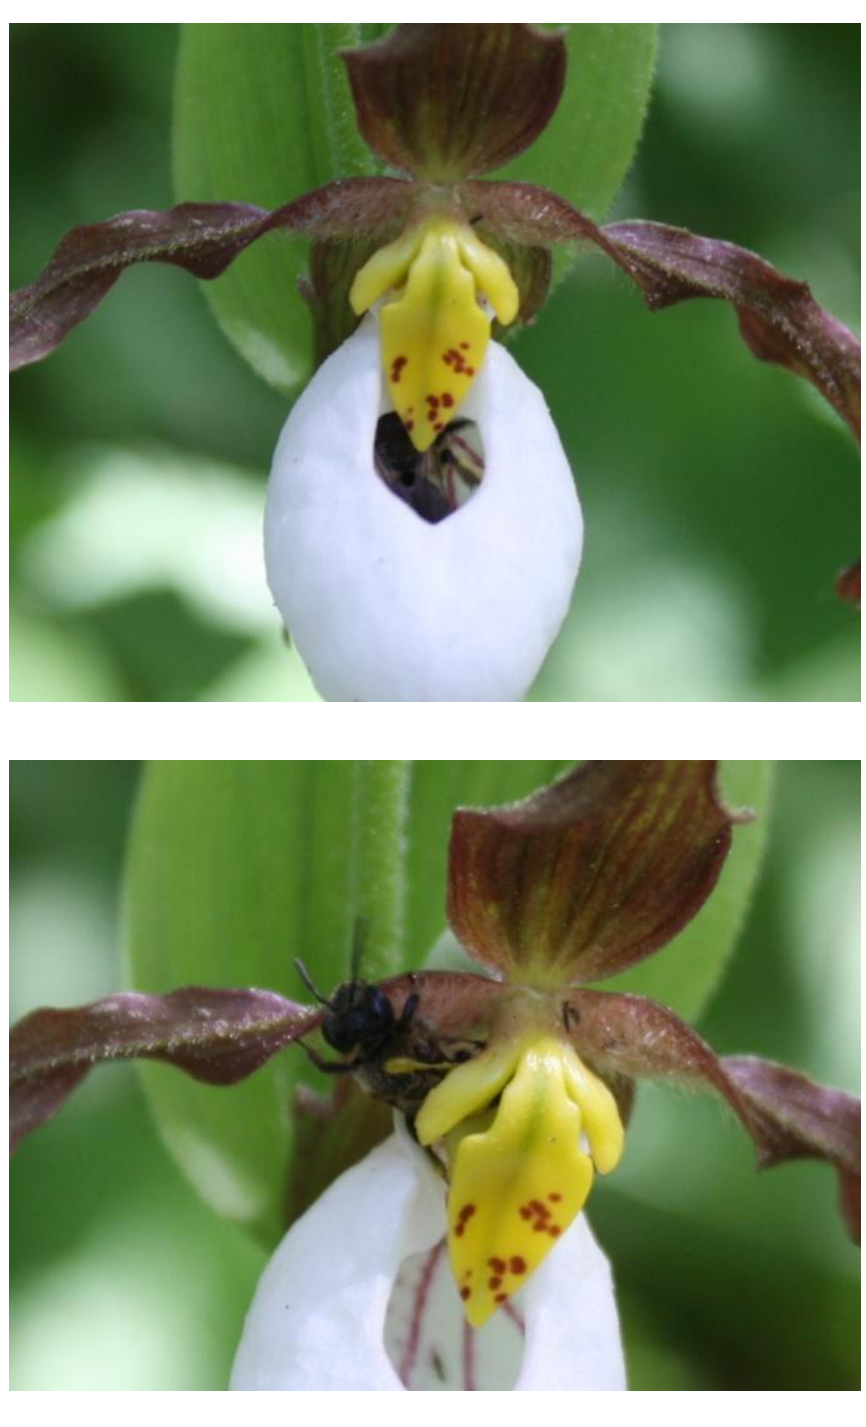
Figure 3. The same bee as in Fig. 1 emerges from the basal opening. Note the yellow pollen smear deposited on the thorax. Also, note that the bee escapes the interior of the labellum while clutching the lateral petal (Photograph by Nan